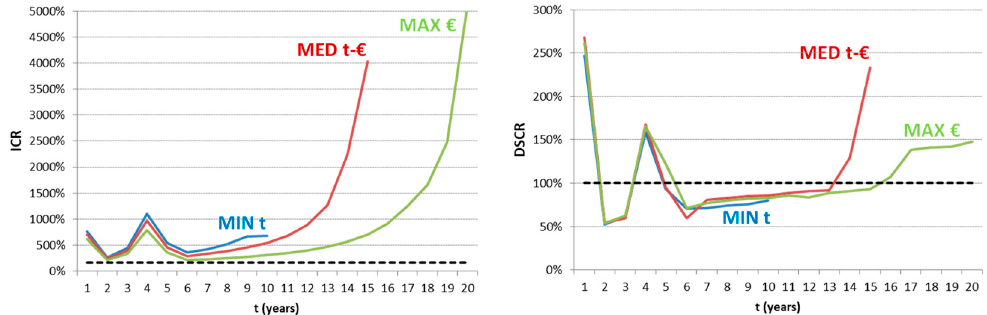
Figure 7. Trend over time of the ICR and DSCR criteria.